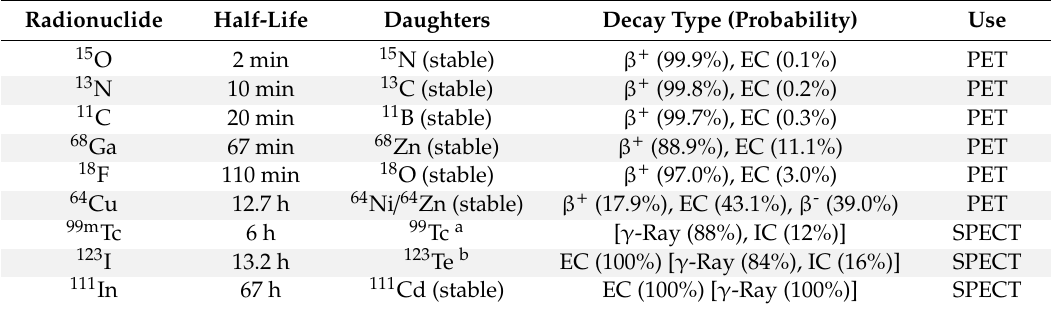
Table 4. Radionuclides commonly used for nuclear medicine